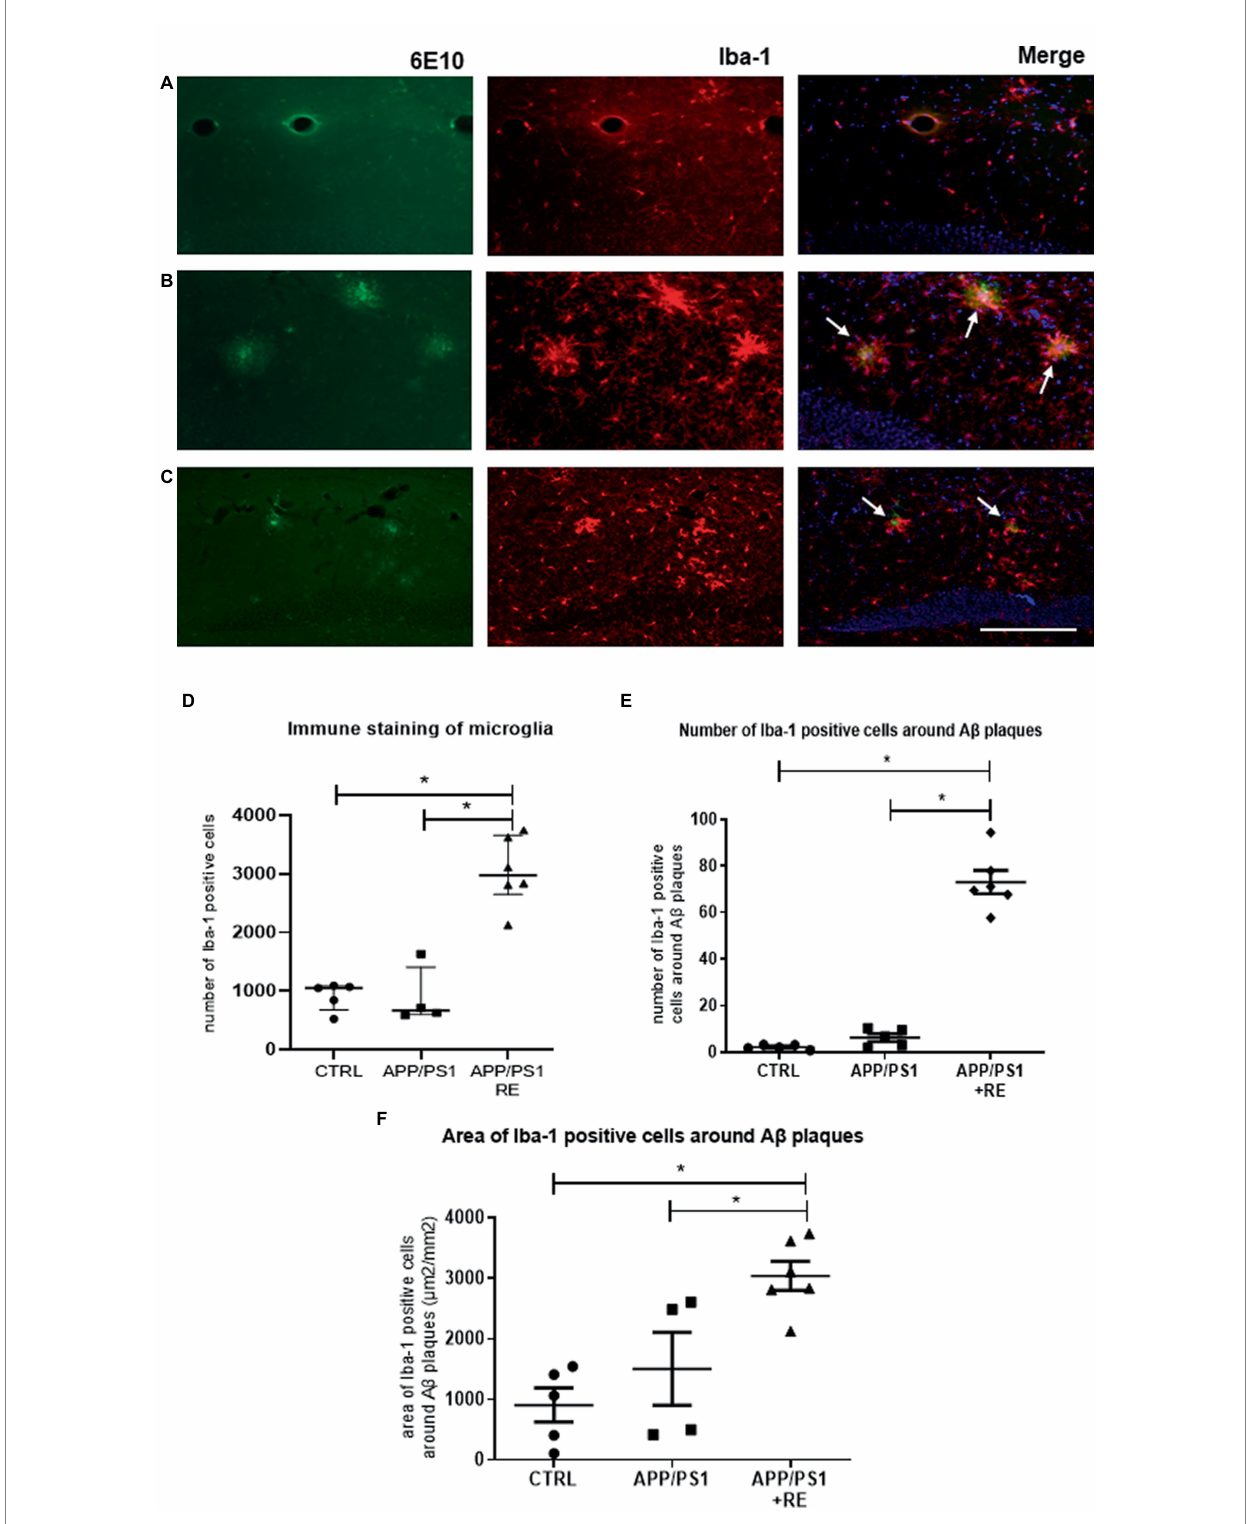
FIGURE 3 Resistance exercise increased the number and the recruitment of microglial cells around A β plaques in the hippocampus of APP/PS1 mice compared to CTRL or APP/PS1 sedentary animals. Representative photomicrographs (scale bar = 50 μ m) of immunofluorescence of A β plaques (6-E10, green), microglia (Iba-1, red), and double-stained (6-E10, green + Iba-1, red) with nuclear marker (DAPI, blue) shown in hippocampal sections of mice from CTRL (A) , APP/PS1 (B) , or APP/PS1 + RE (C) groups, as indicated by arrows. Graph values (mean ± standard error of mean) represent the total number of Iba-1 positive cells (D) , the number of Iba-1 positive cells around the A β plaques (E) , and the area of Iba-1 positive cells around the A β plaques (F) . One- way ANOVA followed by the Dunnett’s post-test, * p < 0.05, n = 4–6